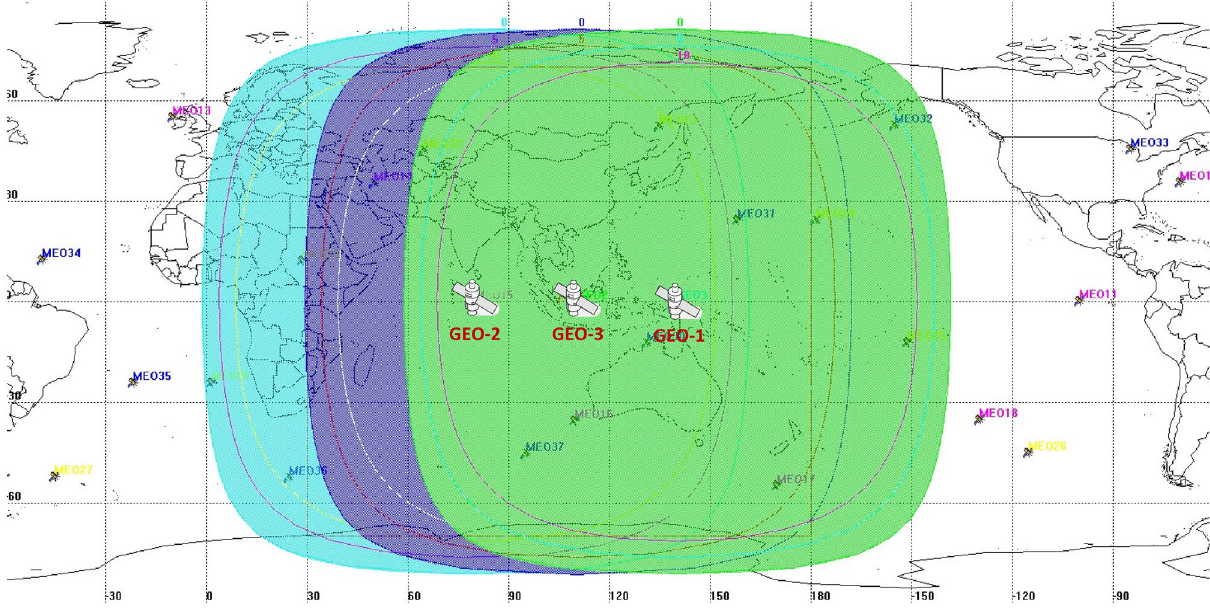
Figure 2. Illustration of the coverage areas for the BDS-3 GEO satellites. The blue, purple and green area shown in the figure are the service areas of the GEO satellites, which are located at 80 °E, 110.5 °E and 140 °E,